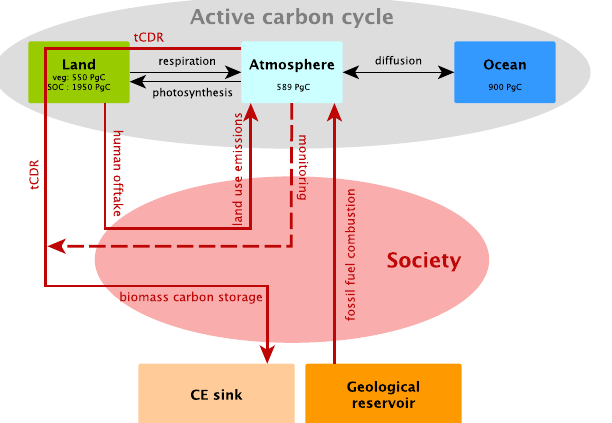
Figure 1. Structure of the co-evolutionary model of societal mon- itoring and terrestrial carbon dioxide removal (tCDR) intervention in the carbon cycle including simulated components of the carbon cycle as well as a societal management feedback loop and their in- teractions. Carbon fluxes are indicated as solid lines and coloured red if influenced by society. Carbon values in the boxes indicate es- timates of pre-industrial carbon pools in the year 1750 AD (Batjes, 1996; Ciais et al., 2013). CE sink is the climate engineering